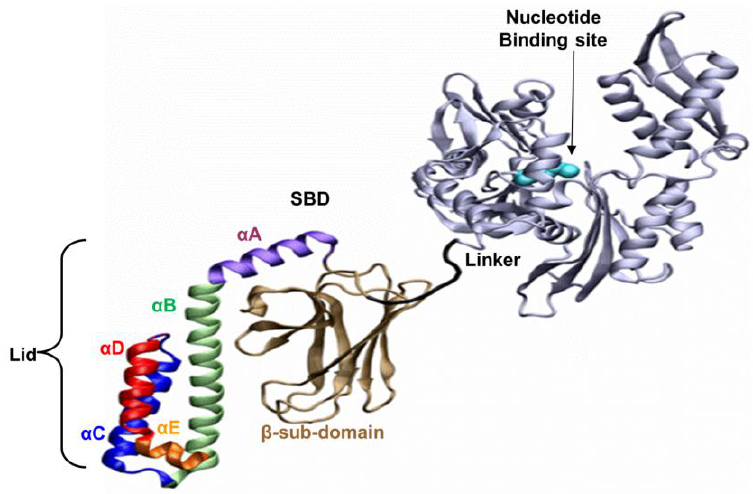
Figure 1. Hsp70 structure . The two functional domains of DnaK: the nucleotide binding domain—NBD (grey), joined to the substrate binding domain—SBD through a linker (black). A peptide substrate can be bound to the cavity in the β-structure and near the lid, whose five different segments are color coded. The presented diagram is missing the 35 residues on the C terminal section that were not resolved by crystallization (PDB ID: